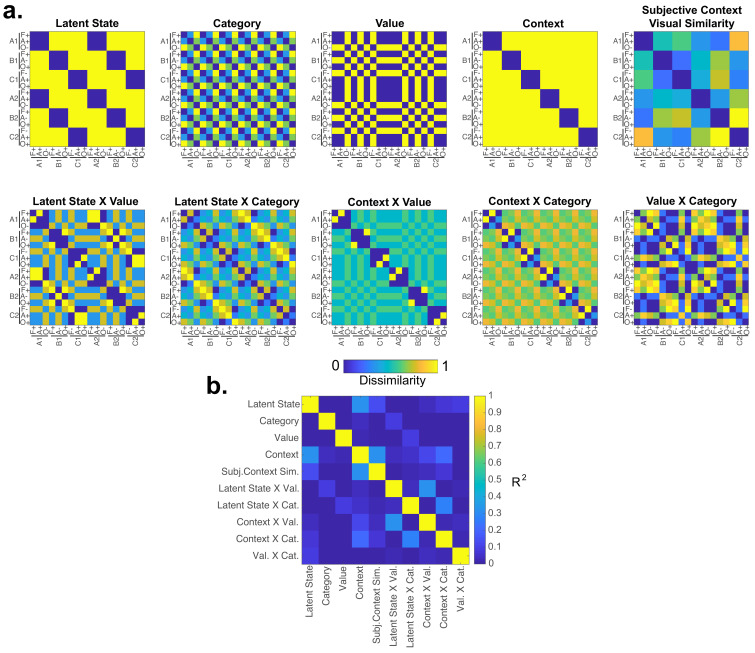
Hypothesis representational dissimilarity matrices (RDMs).(a) All hypothesis RDMs included in the multiple regression analysis for searchlight and ROI-based representational similarity analyses (RSA). Color bar indicates dissimilarity. A, B, C refer to distinct latent states (LSs). A1, B1, C1 and A2, B2, C2 refer to distinct contexts that belong to each of those LSs. F, Faces; A, Animals; O, Objects. +, positive value; −, negative value. (b) Variance shared (R2) between hypothesis RDMs.